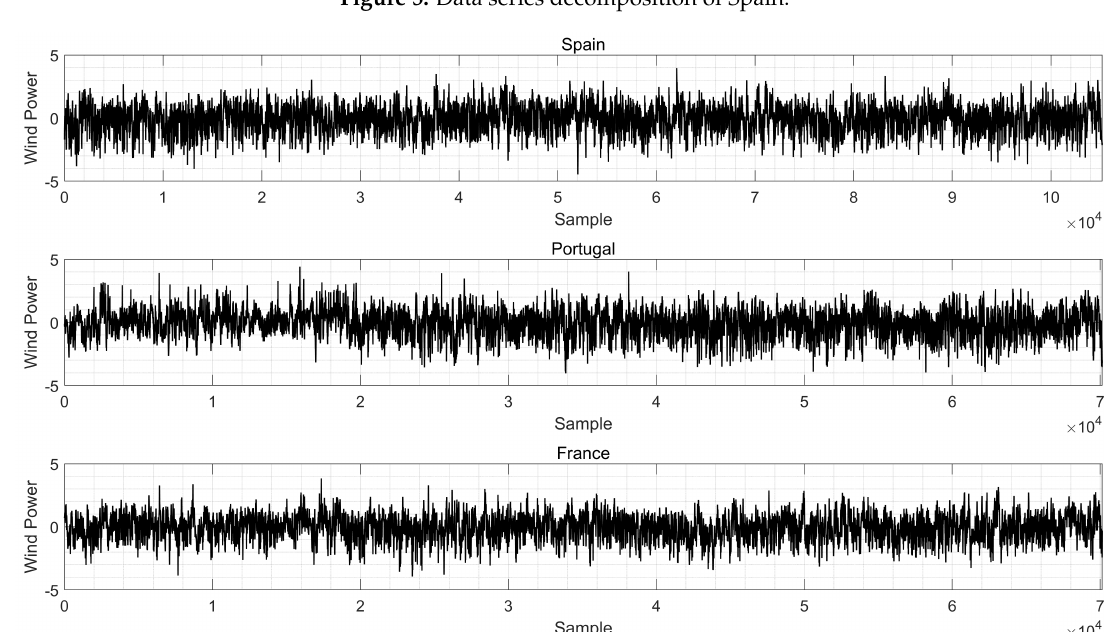
Figure 5. Data series decomposition of Spain.